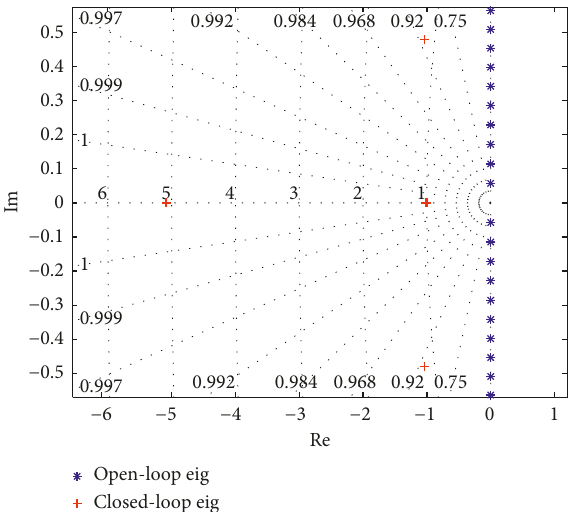
Figure 14: Bode plot for displacement for different control strategies.